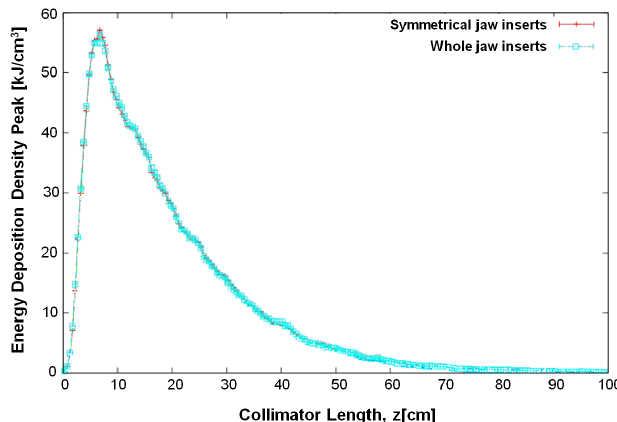
FIG. 9. A comparison of the energy deposition density